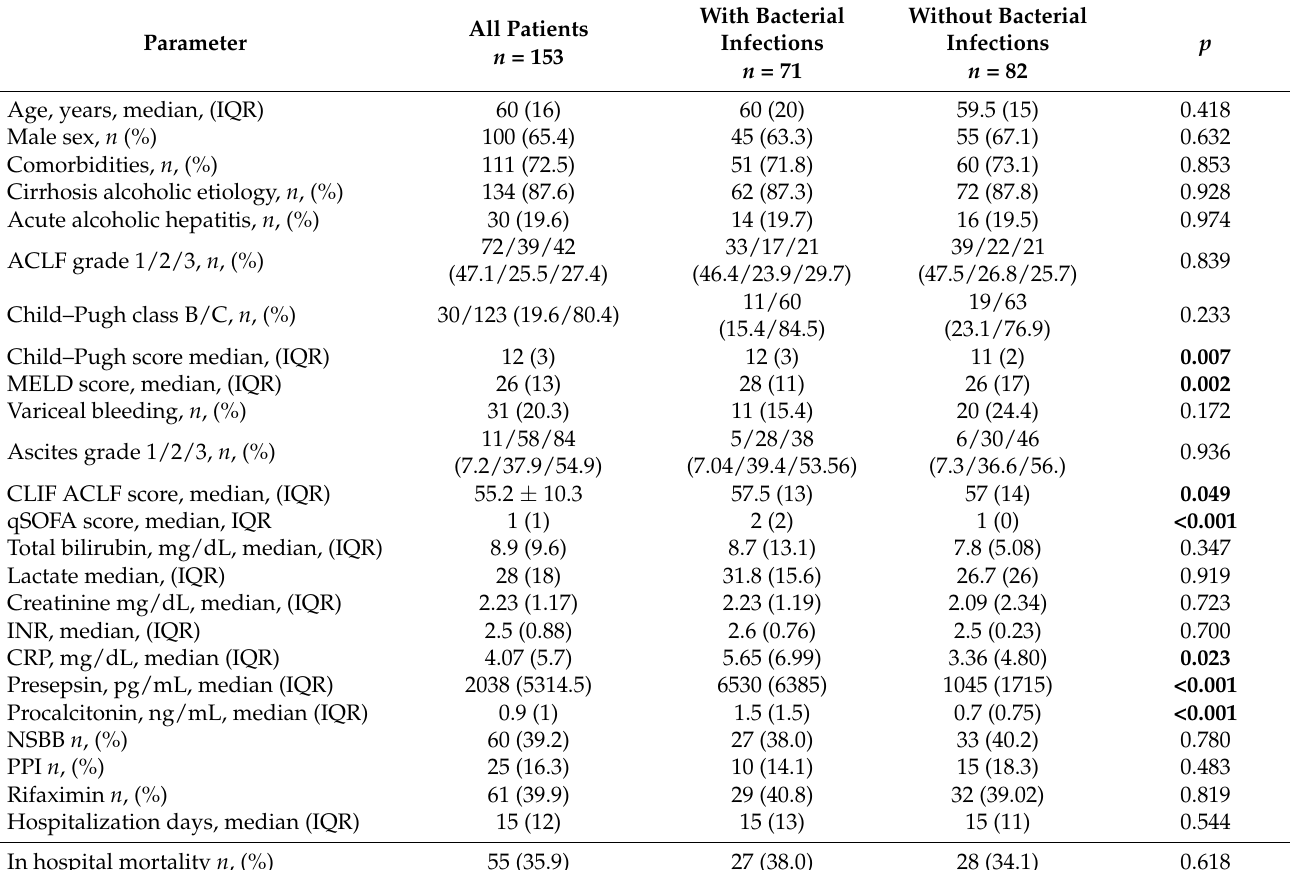
Table 1. Clinical and laboratory characteristics of the study